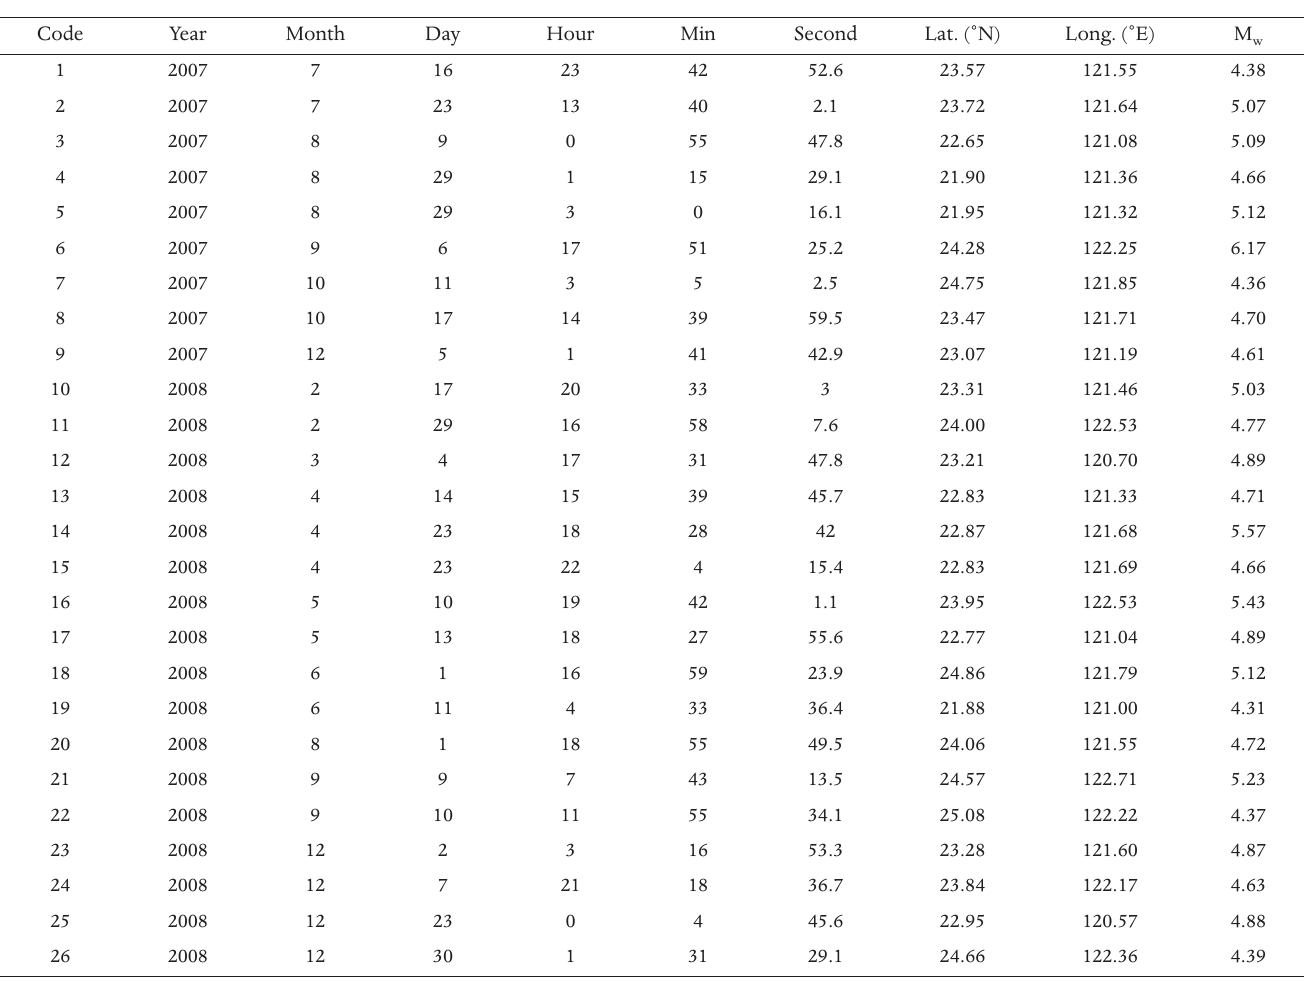
Table 2. Details of the